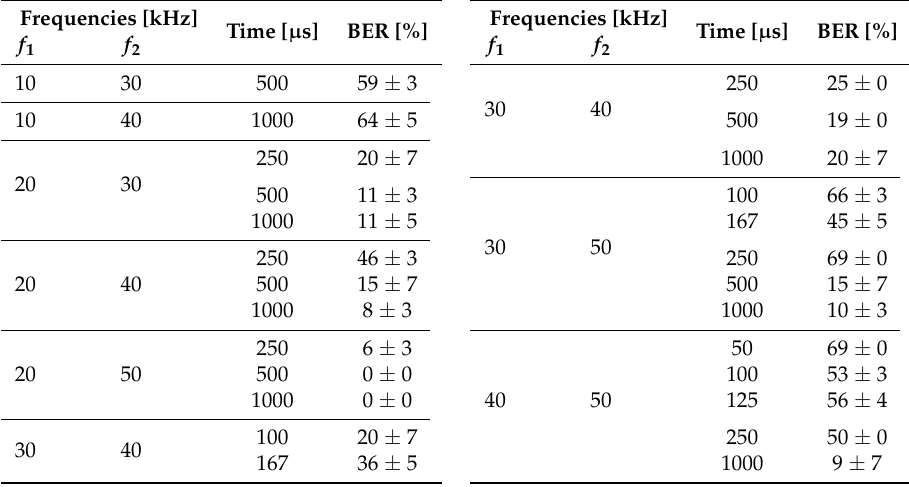
Table 1. Error Bit (BER) of the FSK modulation for a set of measured signals.